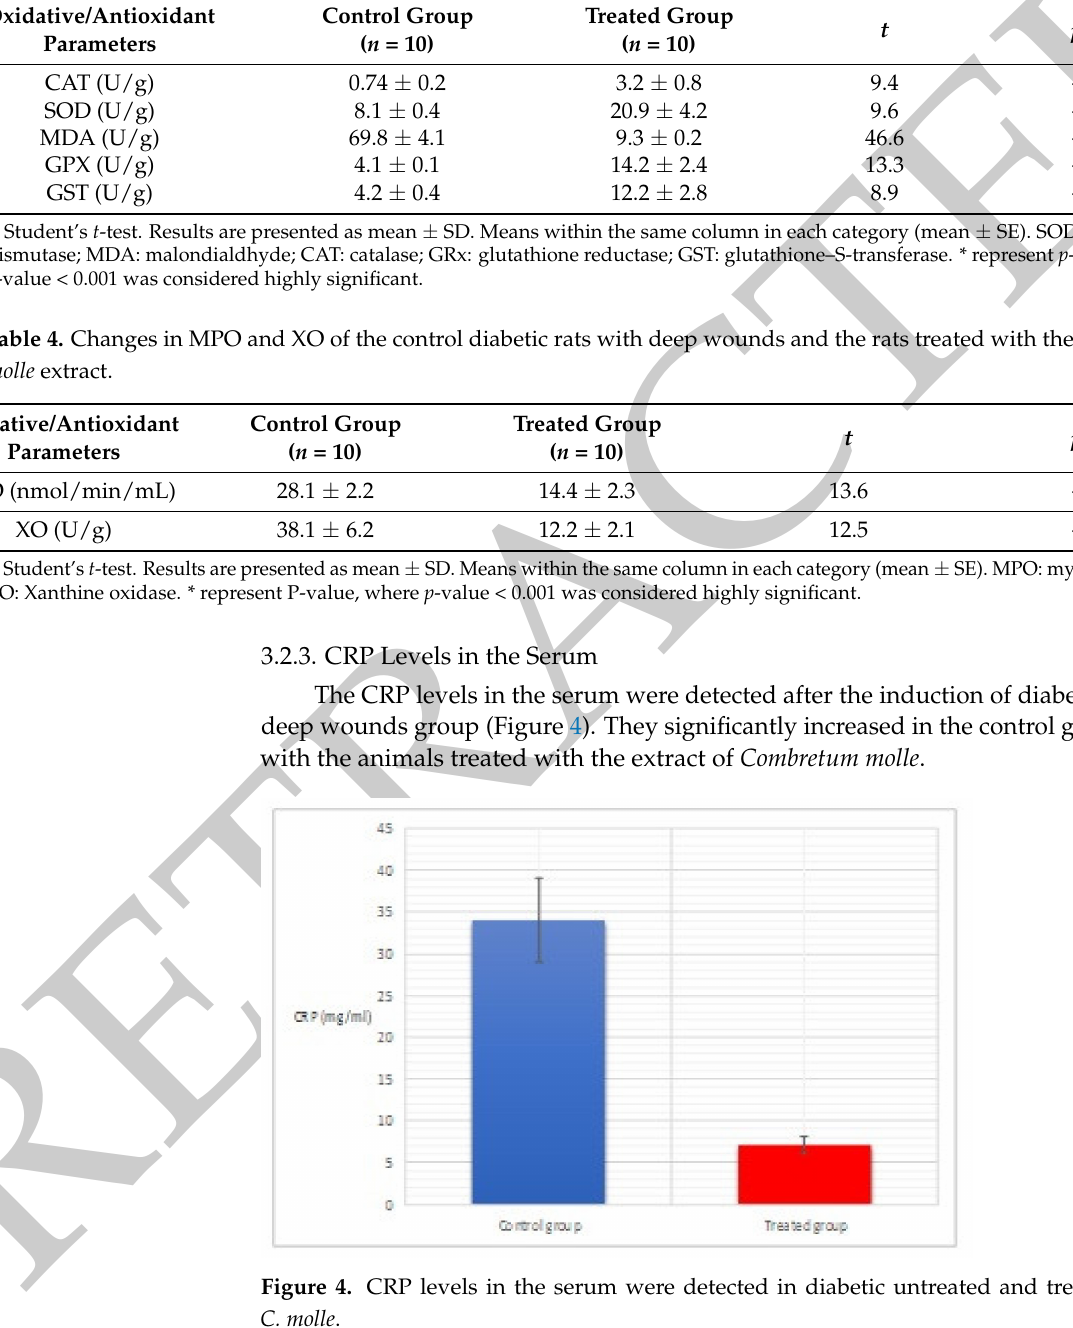
Table 3. Changes in the oxidative/antioxidant parameters of the antioxidant enzymes of the control diabetic rats with deep wounds and the rats treated with the Combretum molle extract. Oxidative/Antioxidant Parameters